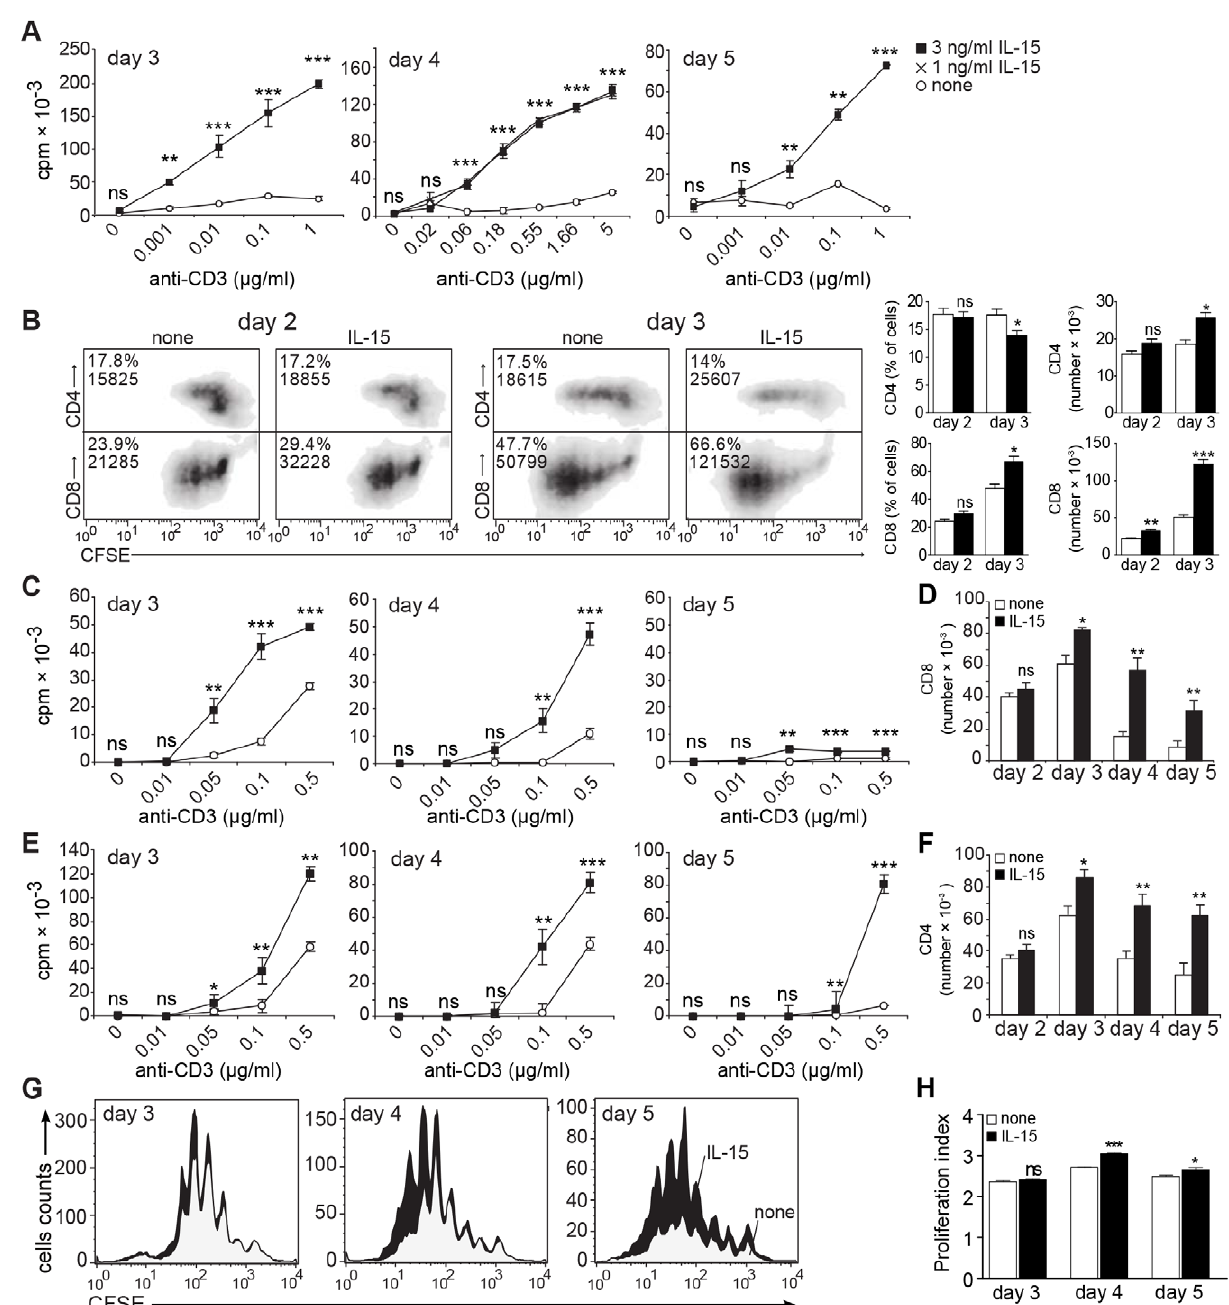
Figure 1. IL-15 enhances the strength and duration of TCR/CD3-triggered proliferation by CD8 + and CD4 + T cells. ( A ) Bulk splenocytes were stimulated with soluble anti-CD3 mAb and 3 H-thymidine incorporation was measured (white circles: none; crosses: 1 ng/ml IL-15; black squares: 3 ng/ml IL-15). ( B ) CFSE-labeled splenocytes were stimulated using 0.1 m g/ml anti-CD3 mAb and supplemented or not with 3 ng/ml rhIL-15. Cells were stained for CD8 or CD4 after 2–3 days. Shown are representative density plots with inset values reflecting percentage and absolute numbers of CD4 + or CD8 + T cells in the viable cell gate and summarizing bar graphs. ( C–F ) CD8 + T cells ( C,D ) or CD4 + T cells ( E,F ) were stimulated with soluble anti-CD3 mAb and irradiated TdACs in the absence or presence of 3 ng/ml rhIL-15. 3 H-thymidine incorporation ( C,E ; white circles: none, black squares: 3 ng/ml IL-15) or cell numbers ( D,F ; 0.1 m g/ml anti-CD3; white bars: none, black bars: 3 ng/ml IL-15) were measured. ( G ) CFSE-labeled CD4 + T cells were stimulated as in F . Shown are CFSE histogram overlays, gated on viable CD4 + T cells, of cultures without (grey) or with (black) exogenous rhIL-15. The heights of the profiles were normalized to the absolute viable CD4 + T cell numbers present in the culture, as determined by flow cytometry using fluorescent micro-beads as a reference. ( H ) Proliferation index of CD4 + T cells in cultures without (white squares) or with (black squares) supplemented IL-15 (3 ng/ml). For all panels, data are from triplicate wells in one representative of four repeat experiments. A, C : Symbols in line graphs reflect mean 6 SD. D, F, H : Bar graphs represent the mean 6 SEM. In all relevant panels, statistical significance between IL-15- supplemented and non-supplemented cultures was calculated per anti-CD3 concentration using student t-test: ns=not significant, * P , 0.05, ** P , 0.01, *** P , 0.001. All experiments were performed at least 3 times with similar results.